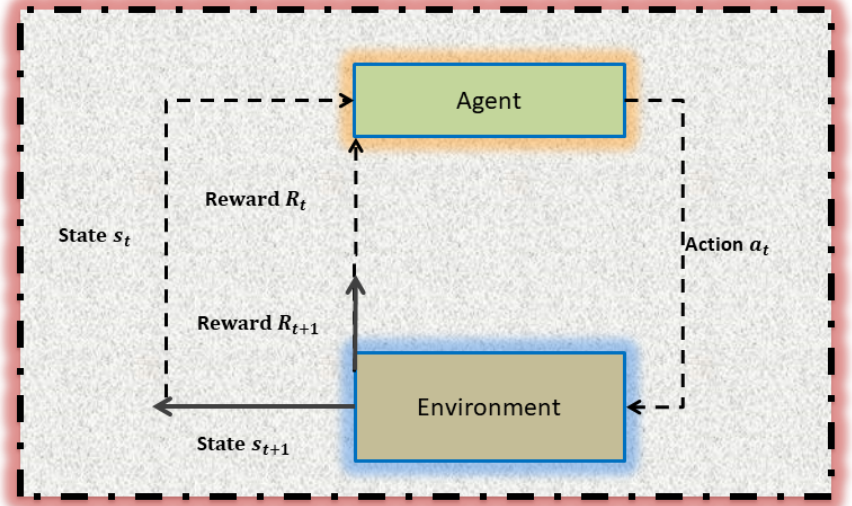
Figure 1. The reinforcement learning